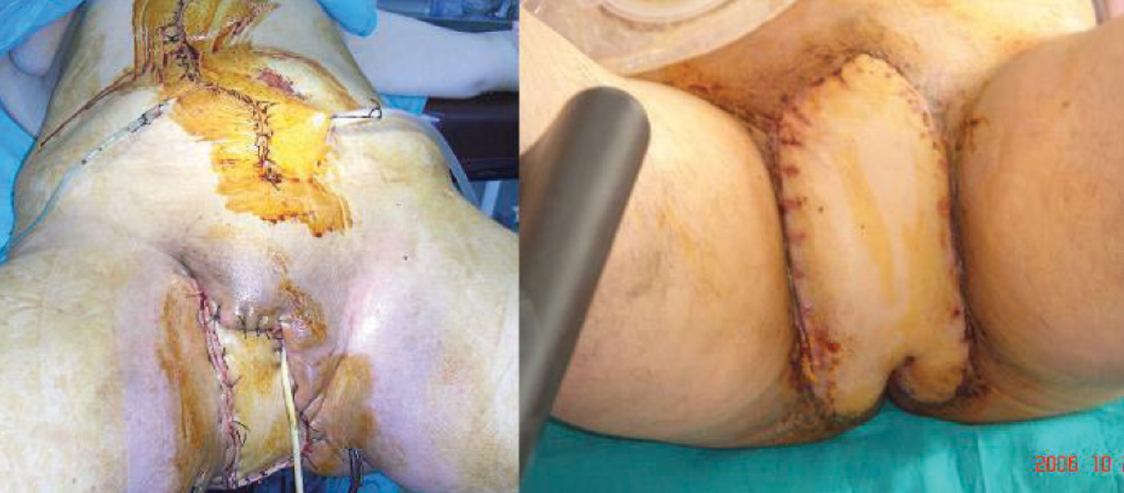
Figure 3. Postoperative